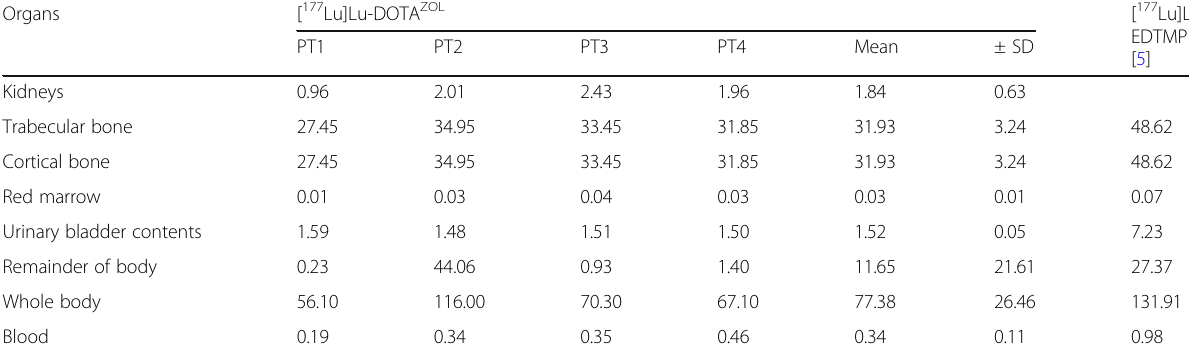
Table 2 Residence times (MBq-h/MBq) of [ 177 Lu]Lu-DOTA ZOL in comparison with [ 177 Lu]Lu-EDTMP [5] Organs